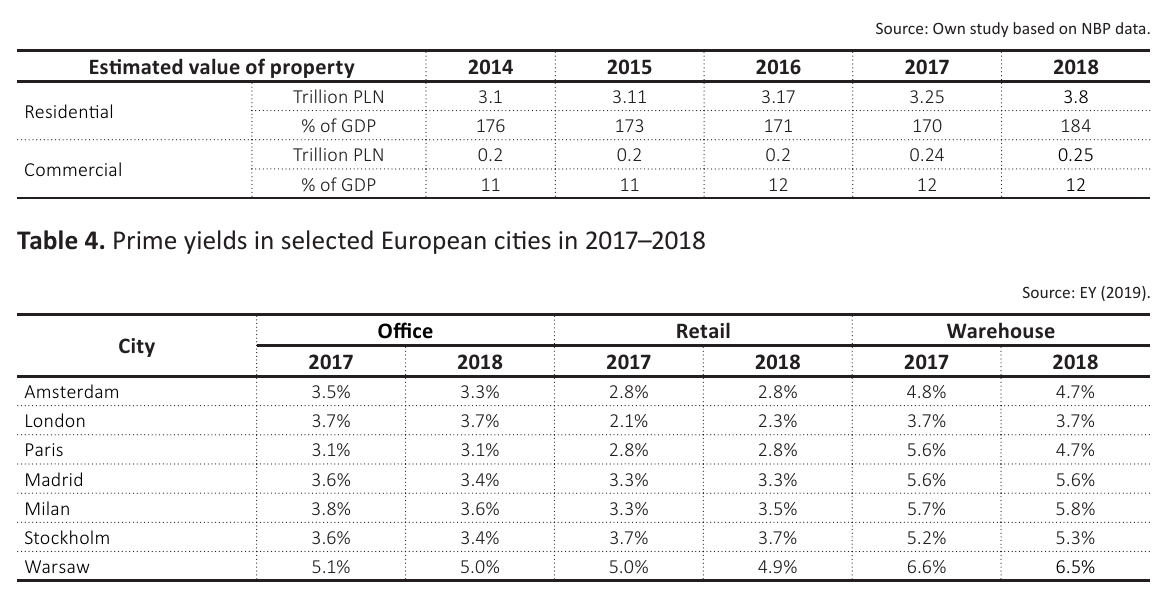
Table 3. Estimated value of property in Poland in 2014–2018